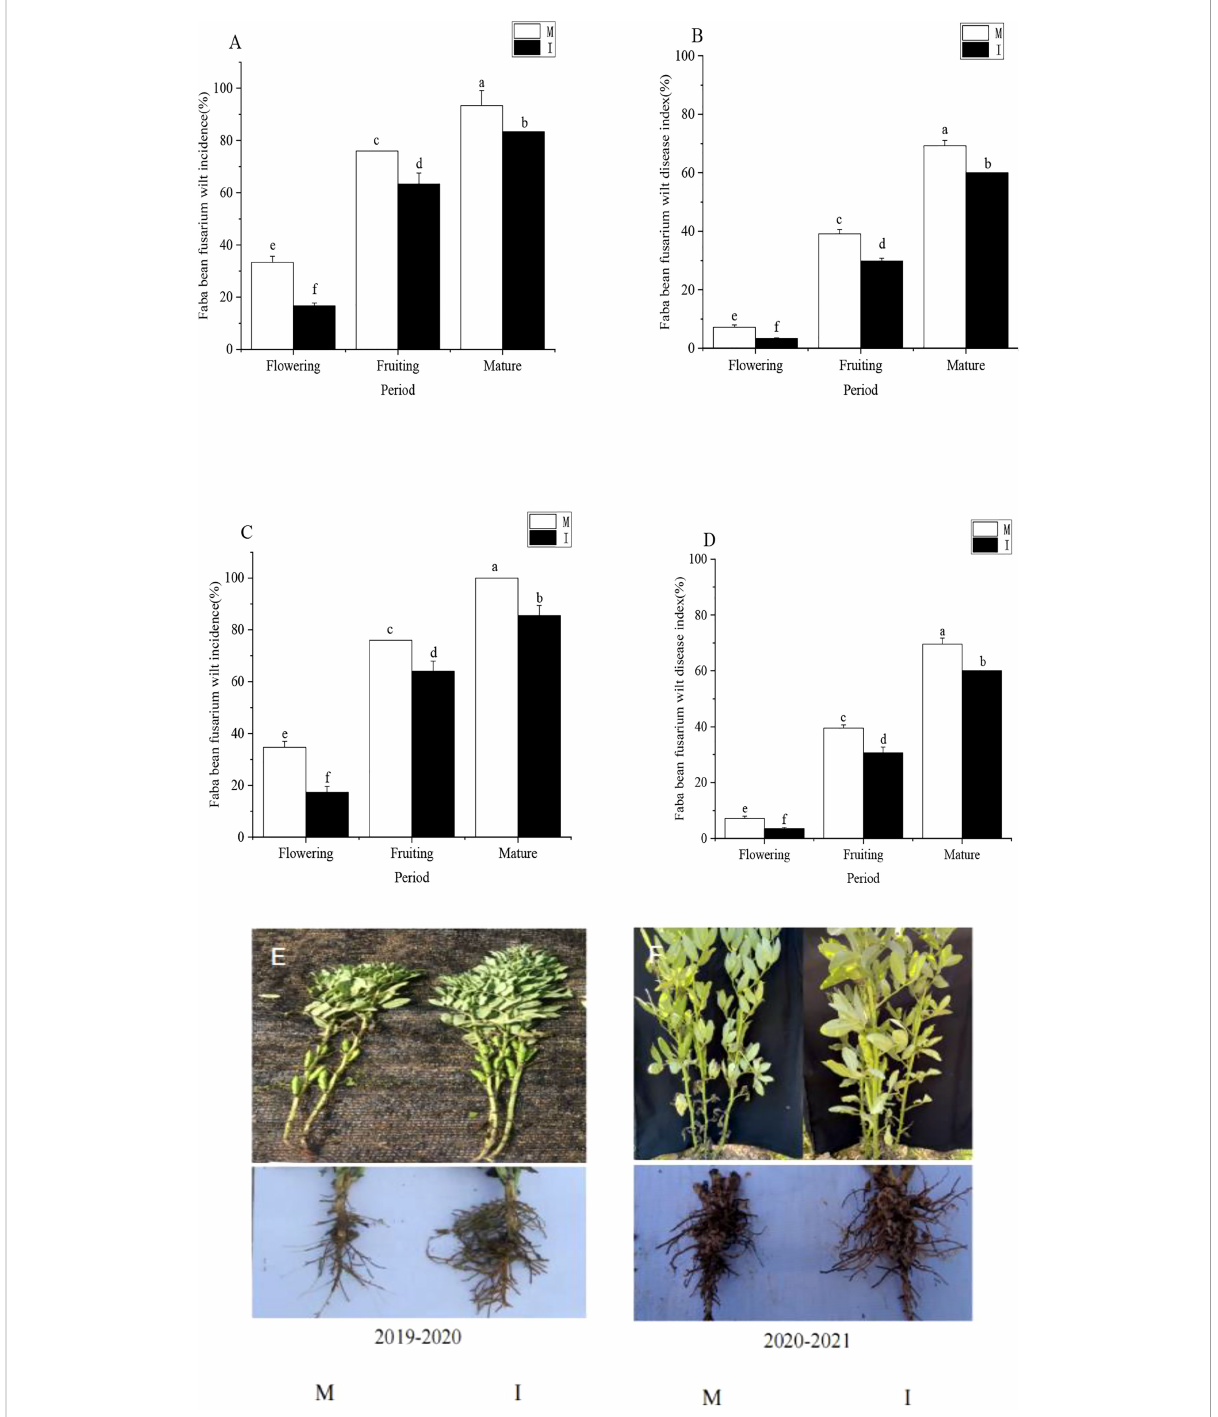
FIGURE 1 (A) Incidence and (B) disease index of Fusarium wilt in faba beans at different stages of growth from October 2019 to May 2020. (C) Incidence and (D) disease index of Fusarium wilt in faba beans at different stages of growth from October 2020 to May 2021. Phenotypic symptomatic pictures of monocropping (E) and intercropping (F) faba beans in the 2019 – 2020 fi eld experiment and 2020 – 2021 fi eld experiment. Data represent mean ± standard error of three biological replicates. M, faba bean monocropping; I, wheat – faba bean intercropping. The data represent the mean ± standard error of three biological replicates. Different letters for each index indicate signi fi cant differences at p < 0.05 (Tukey ’ s